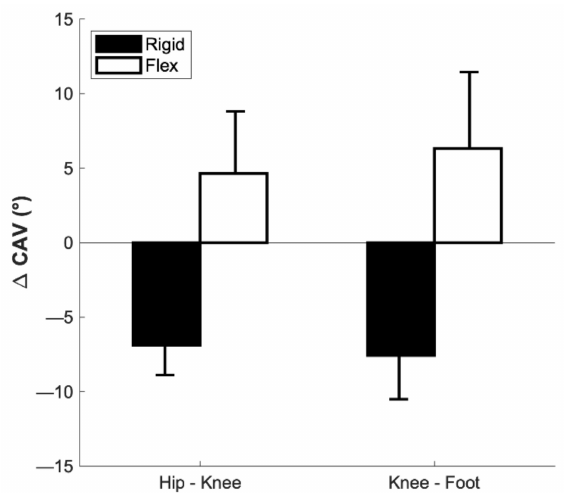
Figure 5. Average change in coupling angle variability (CAV) among the two joint pairings for the three participants who reduced their CAV baseline to post-feedback (Rigid) and the four par- ticipants who increased their CAV baseline to post-feedback (Flex) ( n = 7). Error bars indicate the standard deviation.